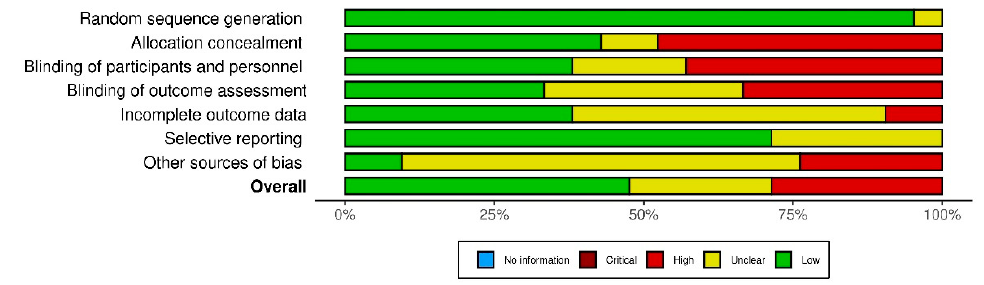
Figure 2. Risk of bias assessment of randomized studies [25,26,43,48,52,55,57,62,66,71,82,109,111,115,